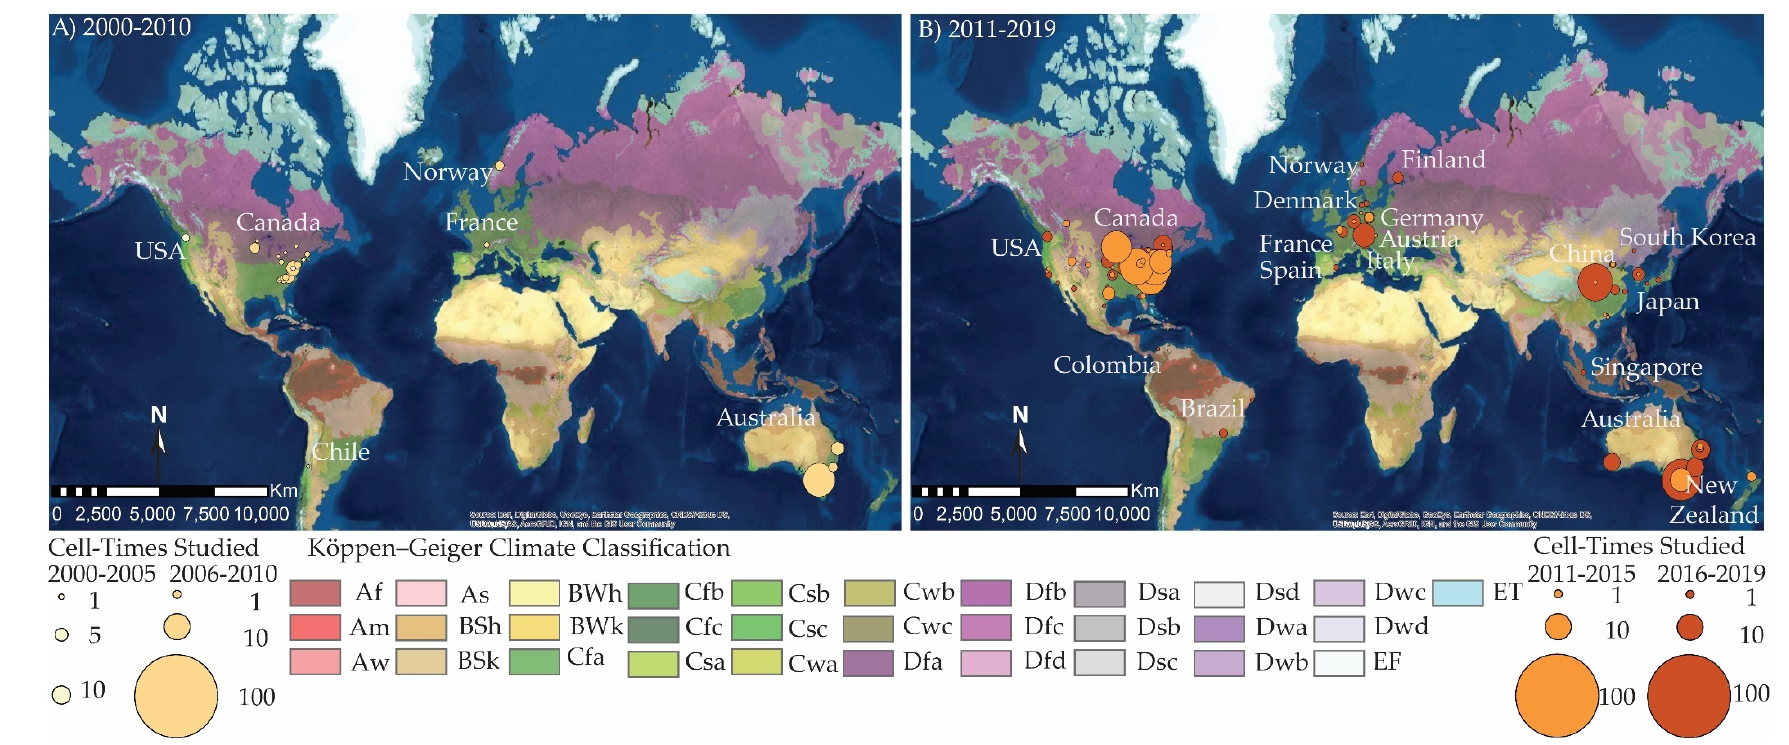
Figure 4. Map showing the locations of studied bioretention cells and global Köppen–Geiger climate classification zones. The circle size represents the number of times bioretention cells were studied during each 5-year time frame within a cluster defined by a 25 km buffer around each bioretention cell. ( A ) Shows the results for the 2000–2005 and 2006–2010 periods, while ( B ) shows the results for the 2011–2015 and the 2016–2019 time periods. Labelled countries/regions are those in which at least one bioretention cell was studied during ( A ) 2000–2010 or ( B ) 2011–2019.